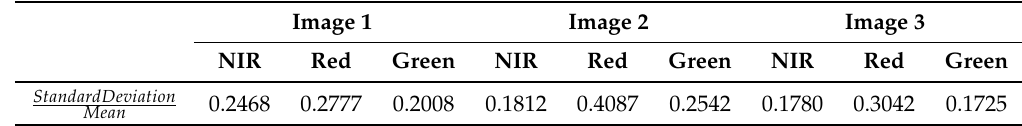
Table 9. Level of details in a target